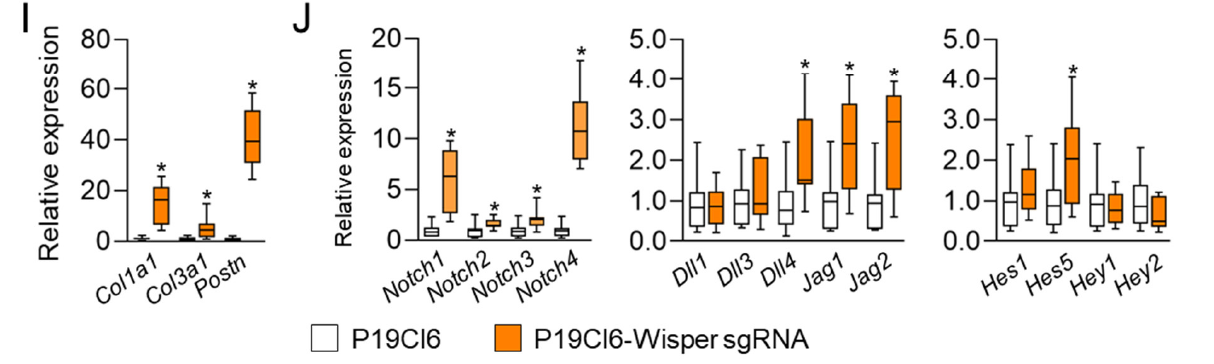
Figure 6. Wisper lncRNA knockdown attenuates adverse cardiac remodeling. ( A ) Experimental pro- tocol. Mice were subjected to transaortic constriction and 2 weeks post-surgery, they received Wisper or Control GapmeRs once a week, for 4 weeks. Hearts were harvested 6 weeks after TAC. ( B ) Cardiac hypertrophy expressed as heart weight-to-tibia length ratio (mg/mm) measured at sacrifice. ( C ) Left ventricle (LV) hypertrophy (LV mass, in mg) measured by echocardiography at 2, 4 and 6 weeks post-TAC. ( D ) Remodeling of LV dimensions (in mm) in diastole and systole (LVID; d and -; s). ( E ) Functional remodeling expressed as percent ejection fraction (%EF) measured by echocardio- graphy at 2, 4 and 6 weeks. ( F , G ) Wisper knockdown attenuates TAC-induced cardiac fibrosis. ( F ) Quantitative RT-PCR analysis of cardiac fibrosis markers Col1a1, Col3a1 and Postn. ( G ) Masson Trichrome staining of heart tissue sections showing interstitial fibrosis (blue) and quantification of fibrosis areas expressed as a percentage of areas of whole heart tissue sections. ( H ) RT-PCR analysis of cardiac stress markers Nppa, Nppb, Myh7 and Myh7/Myh6 ratio. In ( F , H ), expression level is relative to Sham-operated, Control GapmeR-treated group. *, p < 0.05 in TAC vs. Sham; †, p < 0.05 in Wisper GapmeR vs. Control GapmeR. (Sham Control-GapmeR, n = 6; Sham Wisper-GapmeR, n = 5; TAC-Control-GapmeR-4w; n = 6; TAC-Wisper-GapmeR-4w, n = 7; TAC- Control-GapmeR-6w, n = 9; TAC-Wisper-GapmeR-6w, n = 10). ( I , J ) Activation of Wisper expression induces fibrosis and Notch pathway genes. The P19Cl6 embryonal carcinoma cell line was transfected with a plasmid encoding dCAs9-vp16-MS2-p65-Hsf1 and a plasmid expressing guide RNA targeting Wisper promoter region to force Wisper expression. Activation of Wisper expression induces fibrosis marker genes ( I ) and Notch pathway genes ( J ), as evaluated by quantitative RT-PCR analysis. Mean ± SEM *, p < 0.05 in P19Cl6-Wisper sgRNA vs. P19Cl6 ( n =